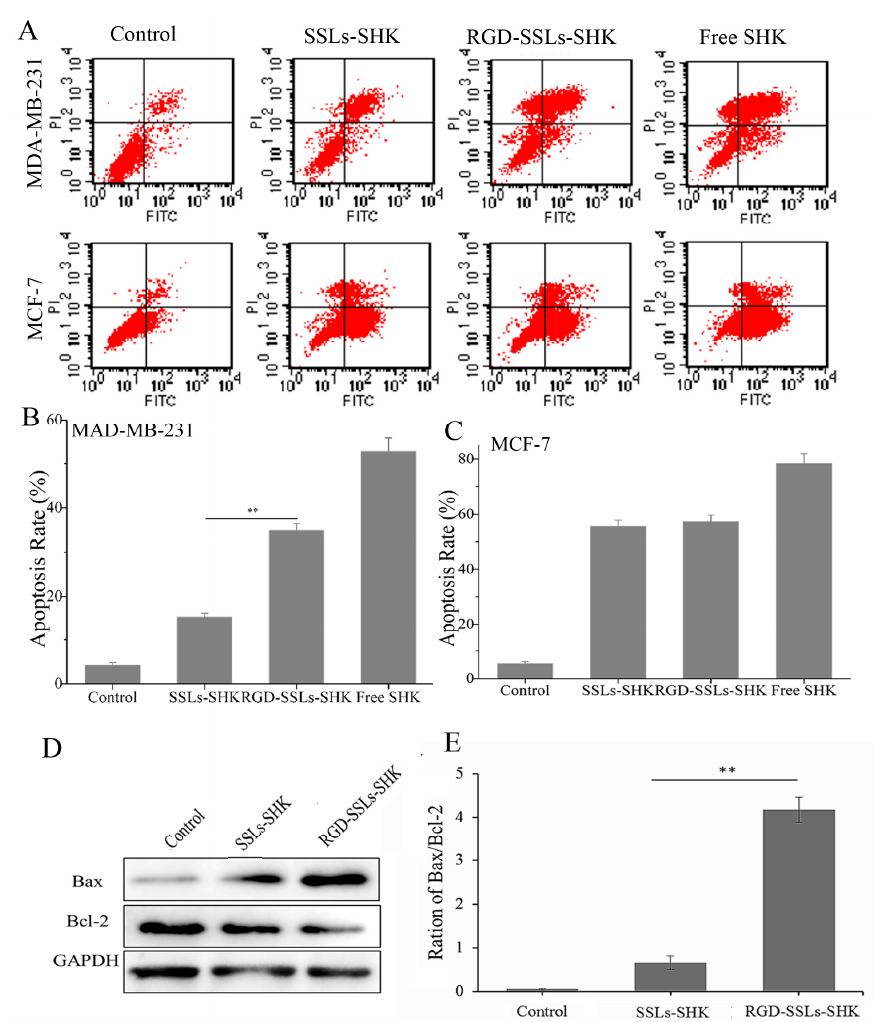
Figure 7. In vitro apoptotic analysis of Control, SSLs-SHK, RGD-SSLs-SHK, and free SHK on the MDA-MB-231 and MCF-7 cells via flow cytometry ( A ); The comparison of apoptosis rate of control, SSLs-SHK, RGD-SSLs-SHK, and free SHK in: MDA-MB-231 cells ( B ); and MCF-7 cells ( C ); Western blot analysis of Bax and Bcl-2 expression after the MDA-MB-231 cells were treated with SSLs-SHK and RGD-SSLs-SHK for 24 h ( D ); The ratio of Bax/Bcl-2 was calculated according to the band intensity